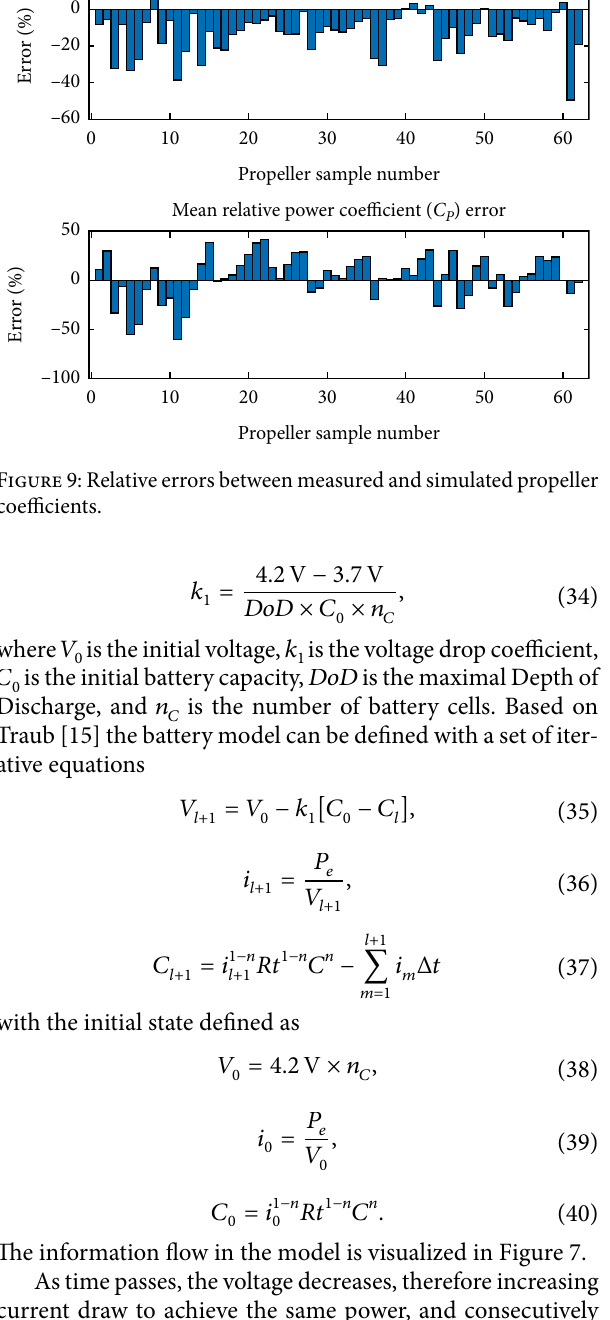
) and power coefficient ( 𝐶 𝑇